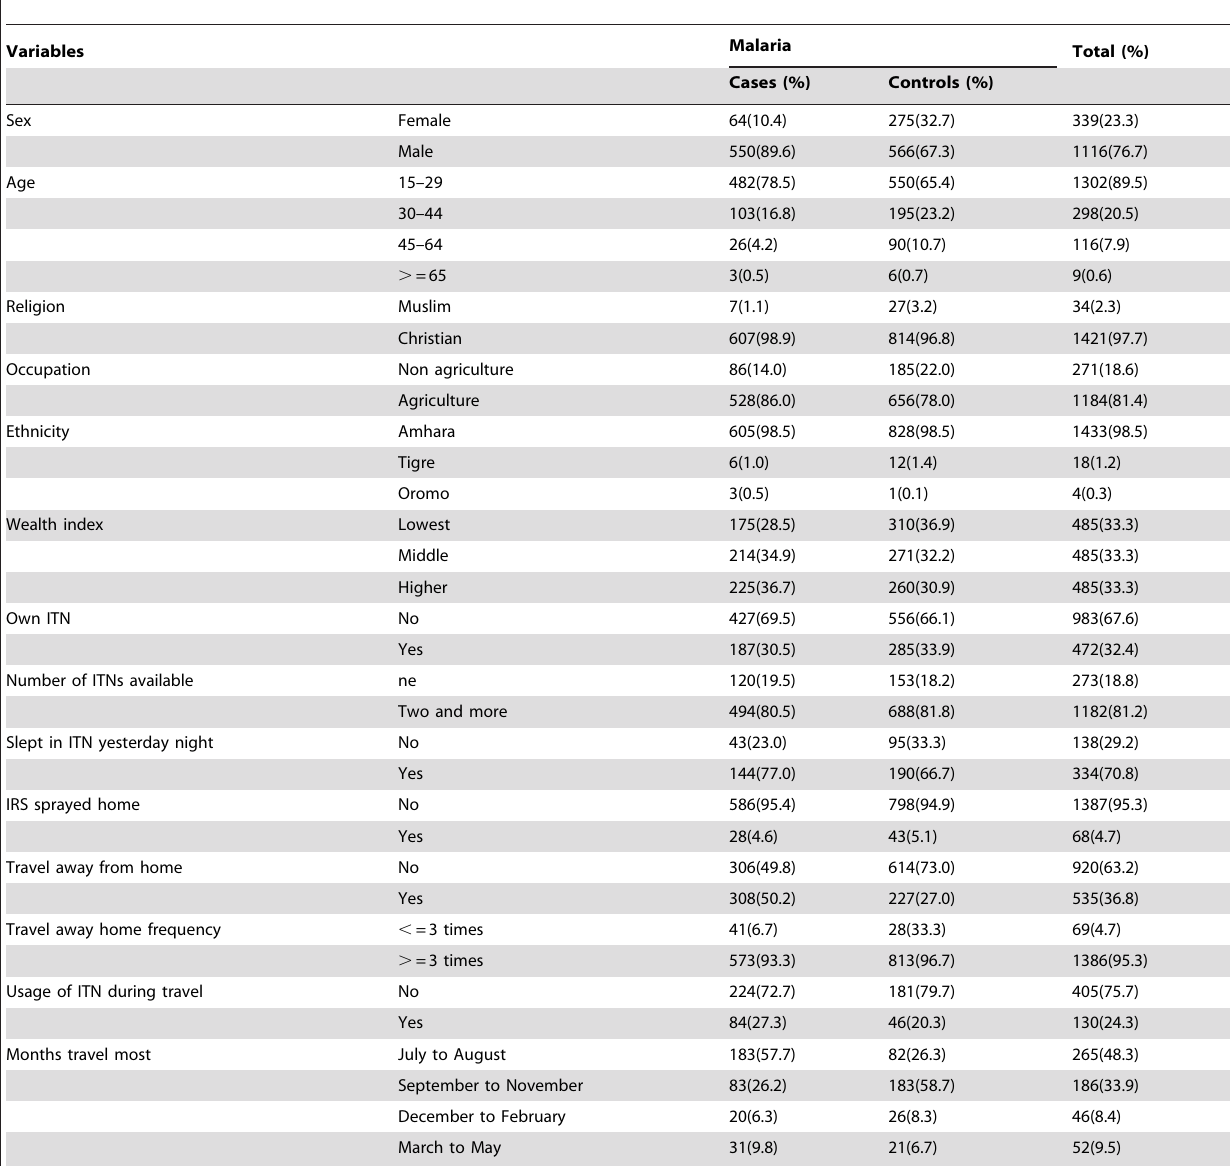
Table 1. Characteristics of the study population in high altitude villages northwest Ethiopia,